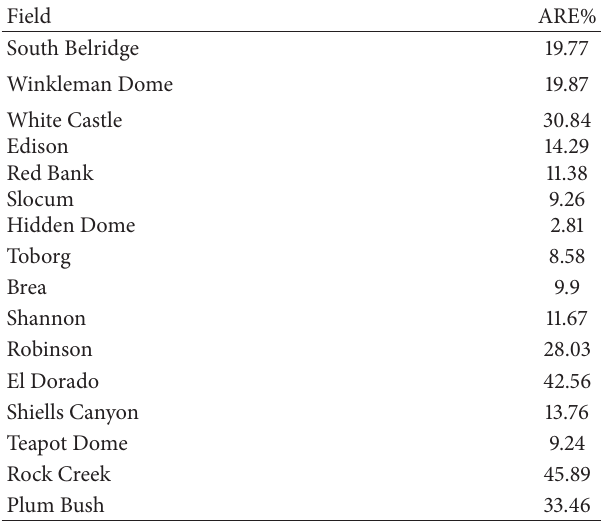
Figure 4: The generalized 𝜋 -shaped membership functions of four input variables. Table 3: Average relative error between simulated results by EOS and experimental